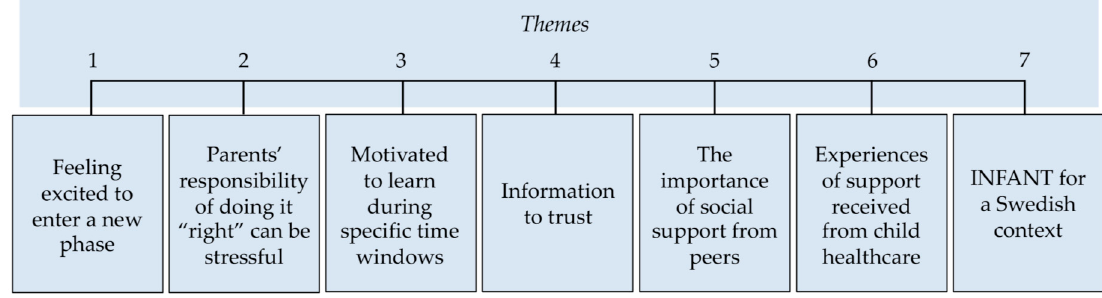
Figure 1. Themes identified during thematic analysis.